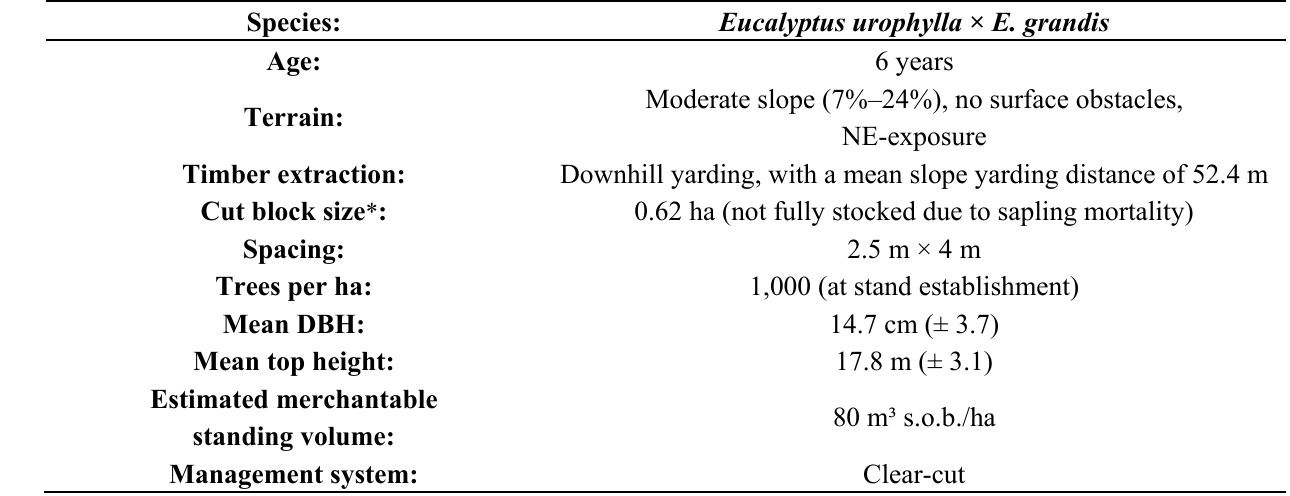
Table 1. Site and stand description with tree characteristics and standard deviations (in